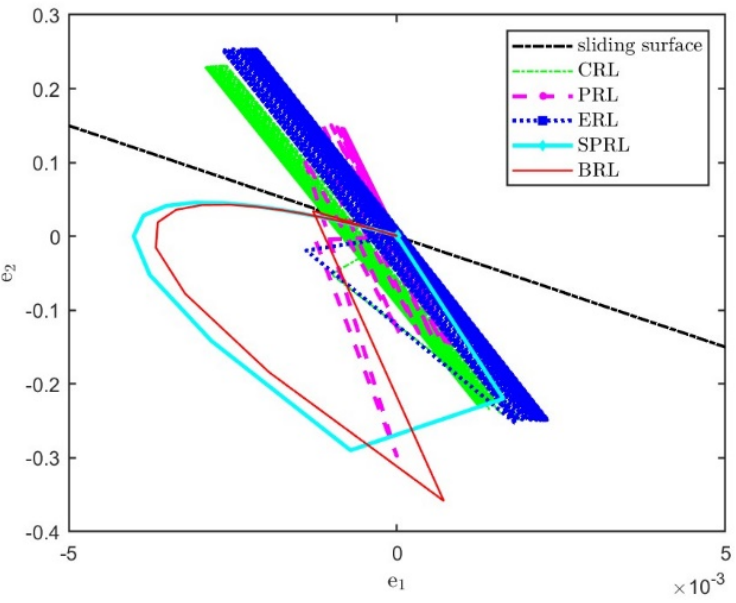
Figure 5. Tracking results of different reaching laws under a sinusoidal signal.